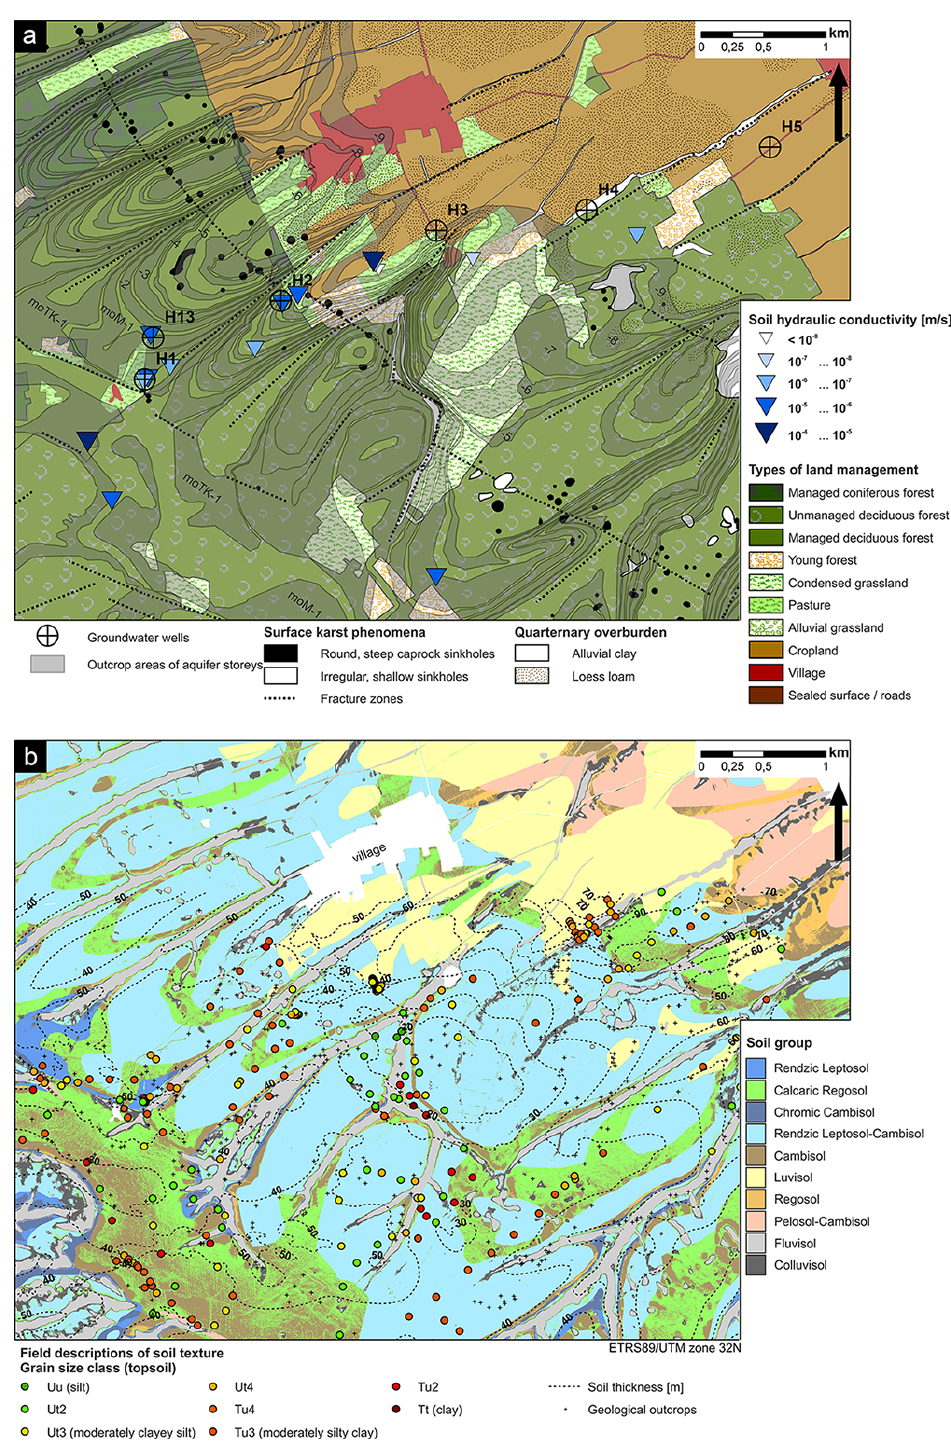
Figure 2. (a) Types of land management, outcrop zones of aquifer storeys, sinkhole lineaments, potential fracture zones, and measurement points for soil hydraulic conductivities. Aquifer storeys which are lower in stratigraphy outcrop in higher positions on the Hainich hillslope. The AquaDiva well transect H1 to H5 (also shown) covers hillslope regions from the summit (H1) to the footslope (H5). (b) Soil map showing calculated soil groups and mapped calibration data points. Signatures of the mapped soil profiles represent the grain size class (soil category) of the topsoil. Interpolated isolines of mapped soil thickness show increasing thickness towards the north-east and towards the transverse